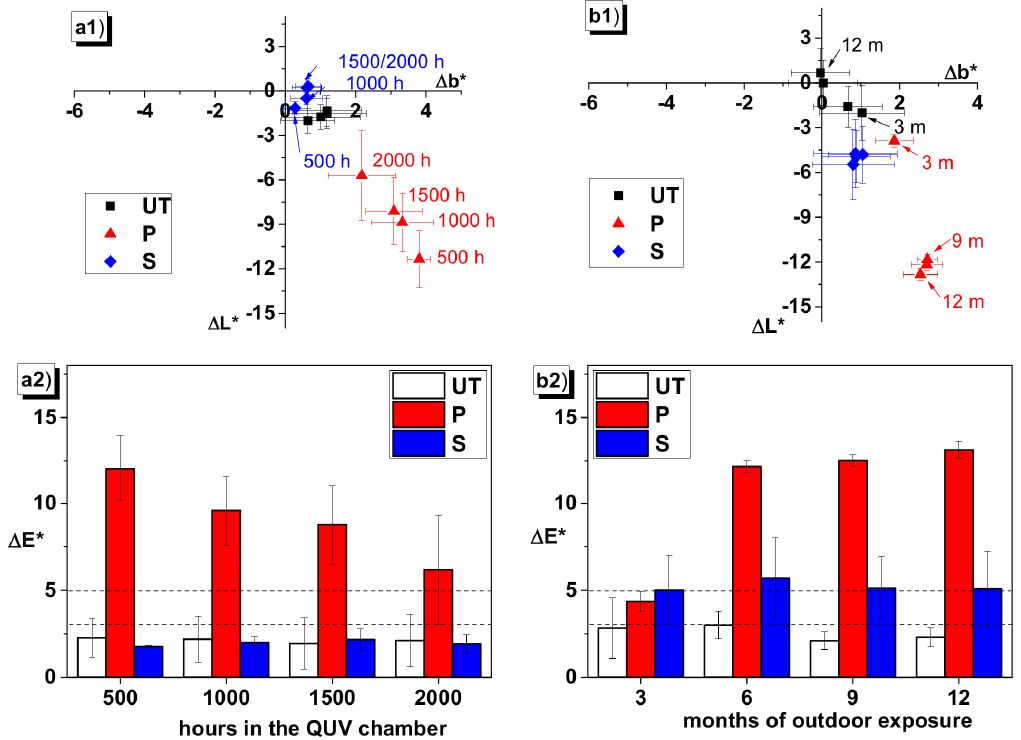
Figure 2. Variation of chromatic coordinates, L* (luminosity) and b* (yellow hue) ( 1 ), and overall total colour, Δ E * ( 2 ) of surfaces of concrete: untreated (UT), treated with a permanent (P) and a sacrificial anti ‐ graffiti coating (S) after artificial ( a ) and natural weathering ( b ).